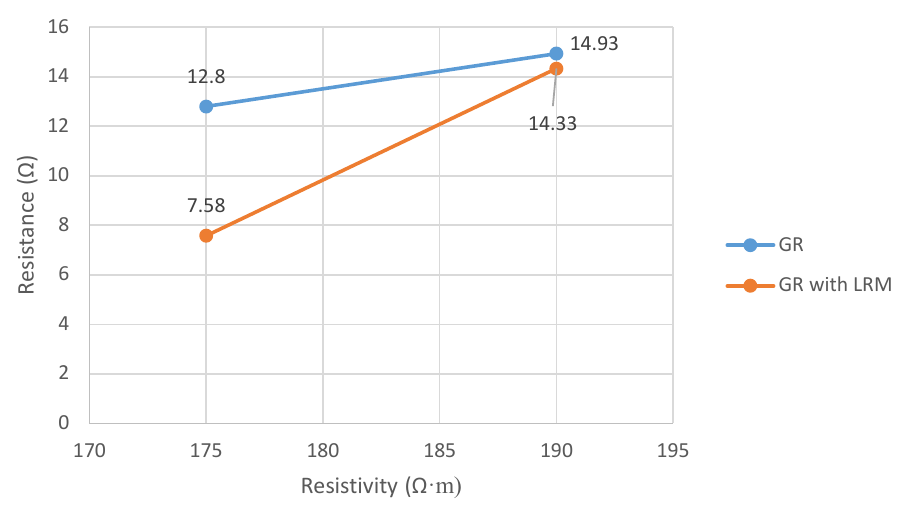
Figure 11. GR vs. 3RT resistivity.